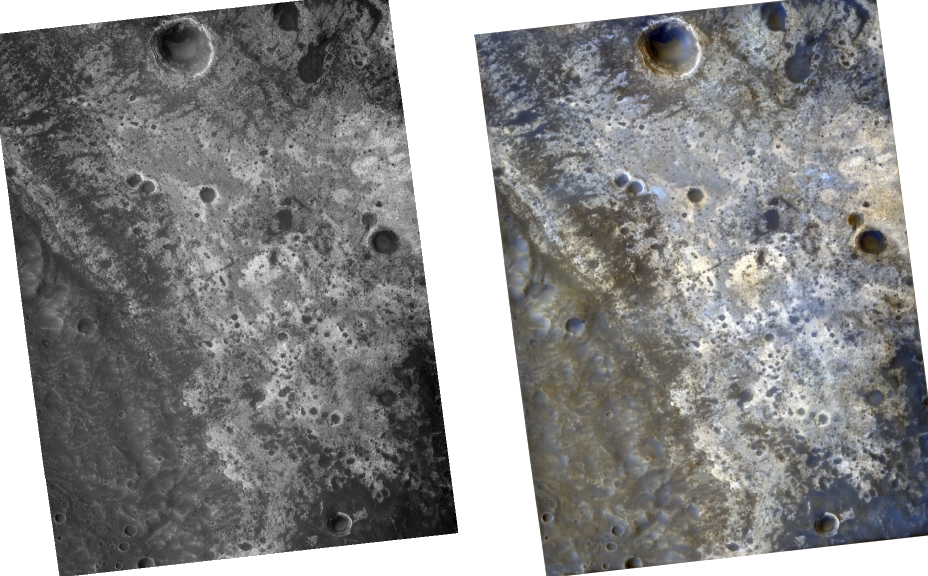
Figure 22. CTX observation B03_010816_2041_XI_24N019W ( left ) next to predicted EVC browse product with s = 2 and Gauss averaging ( right